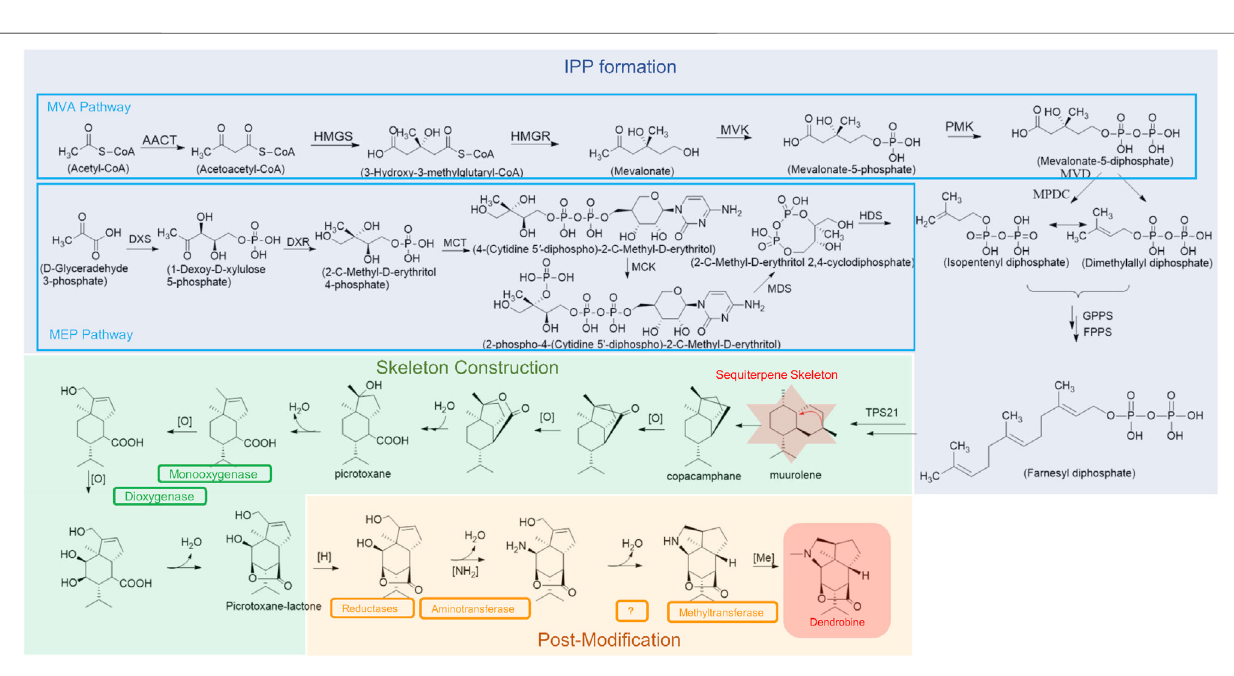
FIGURE 8 | The potential biosynthetic pathway of